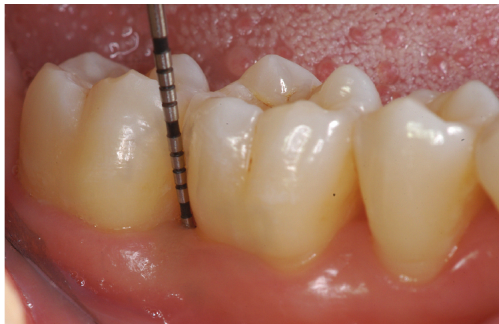
Figure 8: After 12-month follow-up period the periodontal probing show a PD of 3